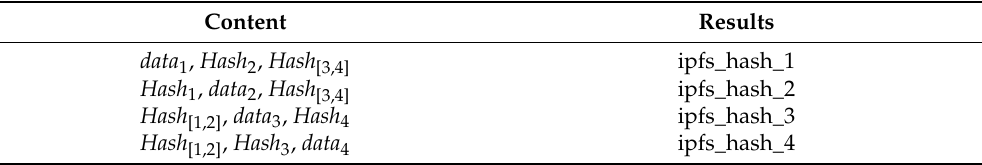
Table 3. Off-chain storage and results.